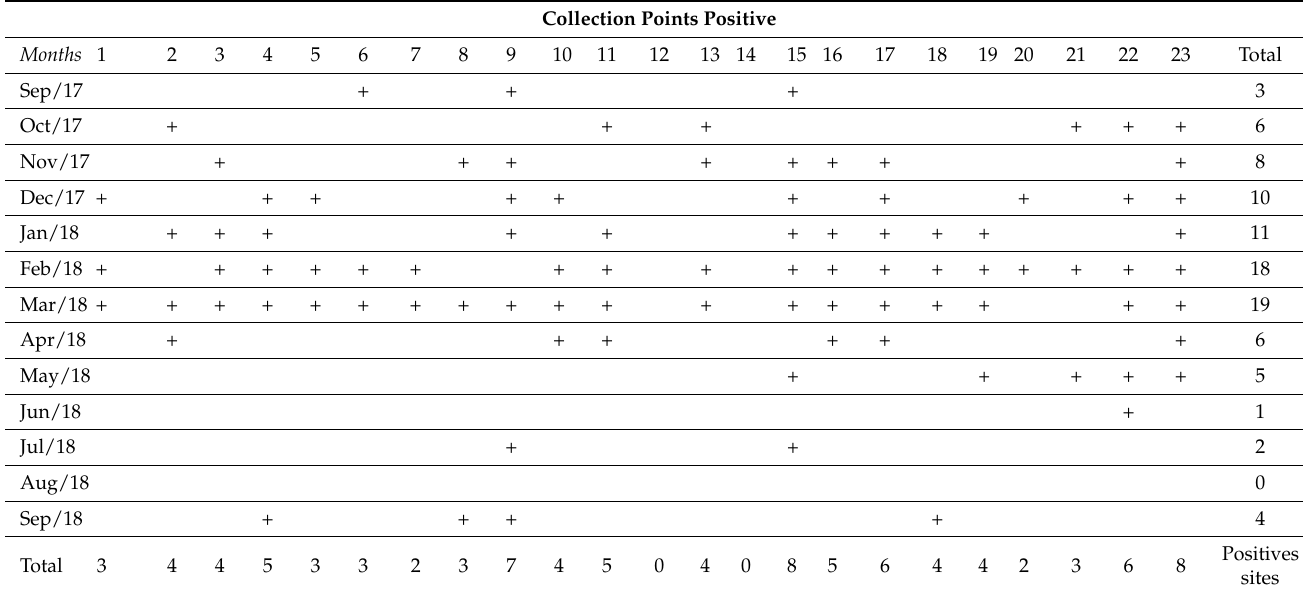
Table 1. Collections sites in the municipality of Morretes, September 2017 to September 2018, Paran á , Brazil.